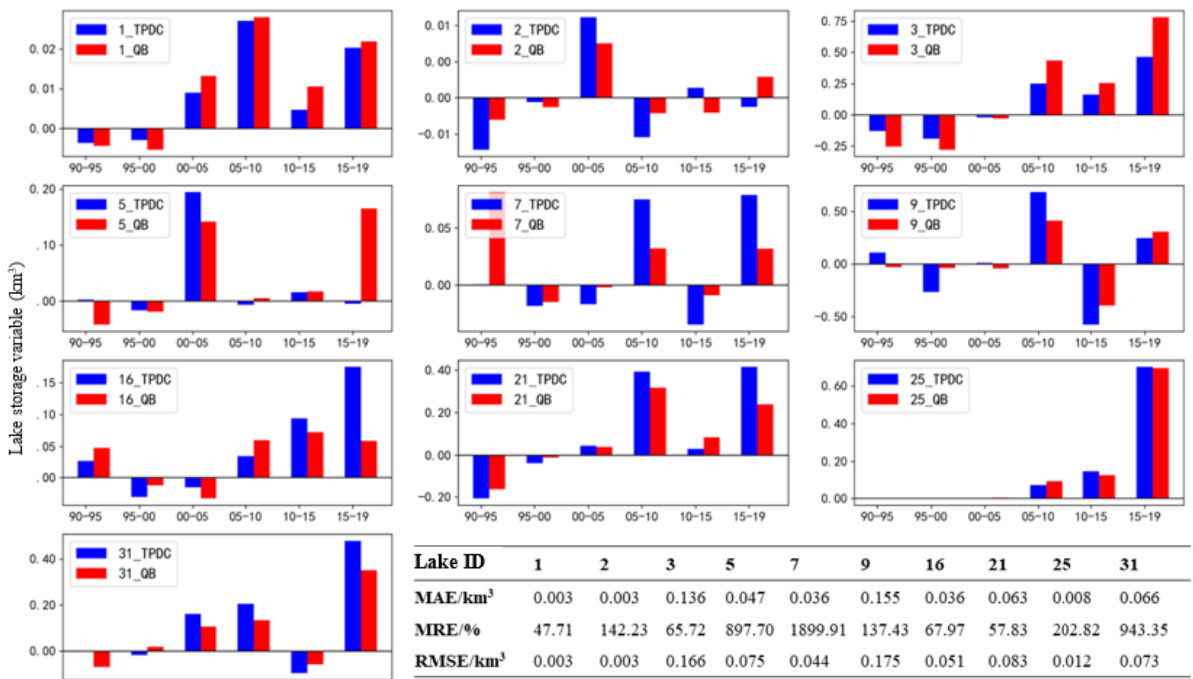
Figure 3. Comparison of lake storage variables obtained from different data sources from 1990 to 2019.